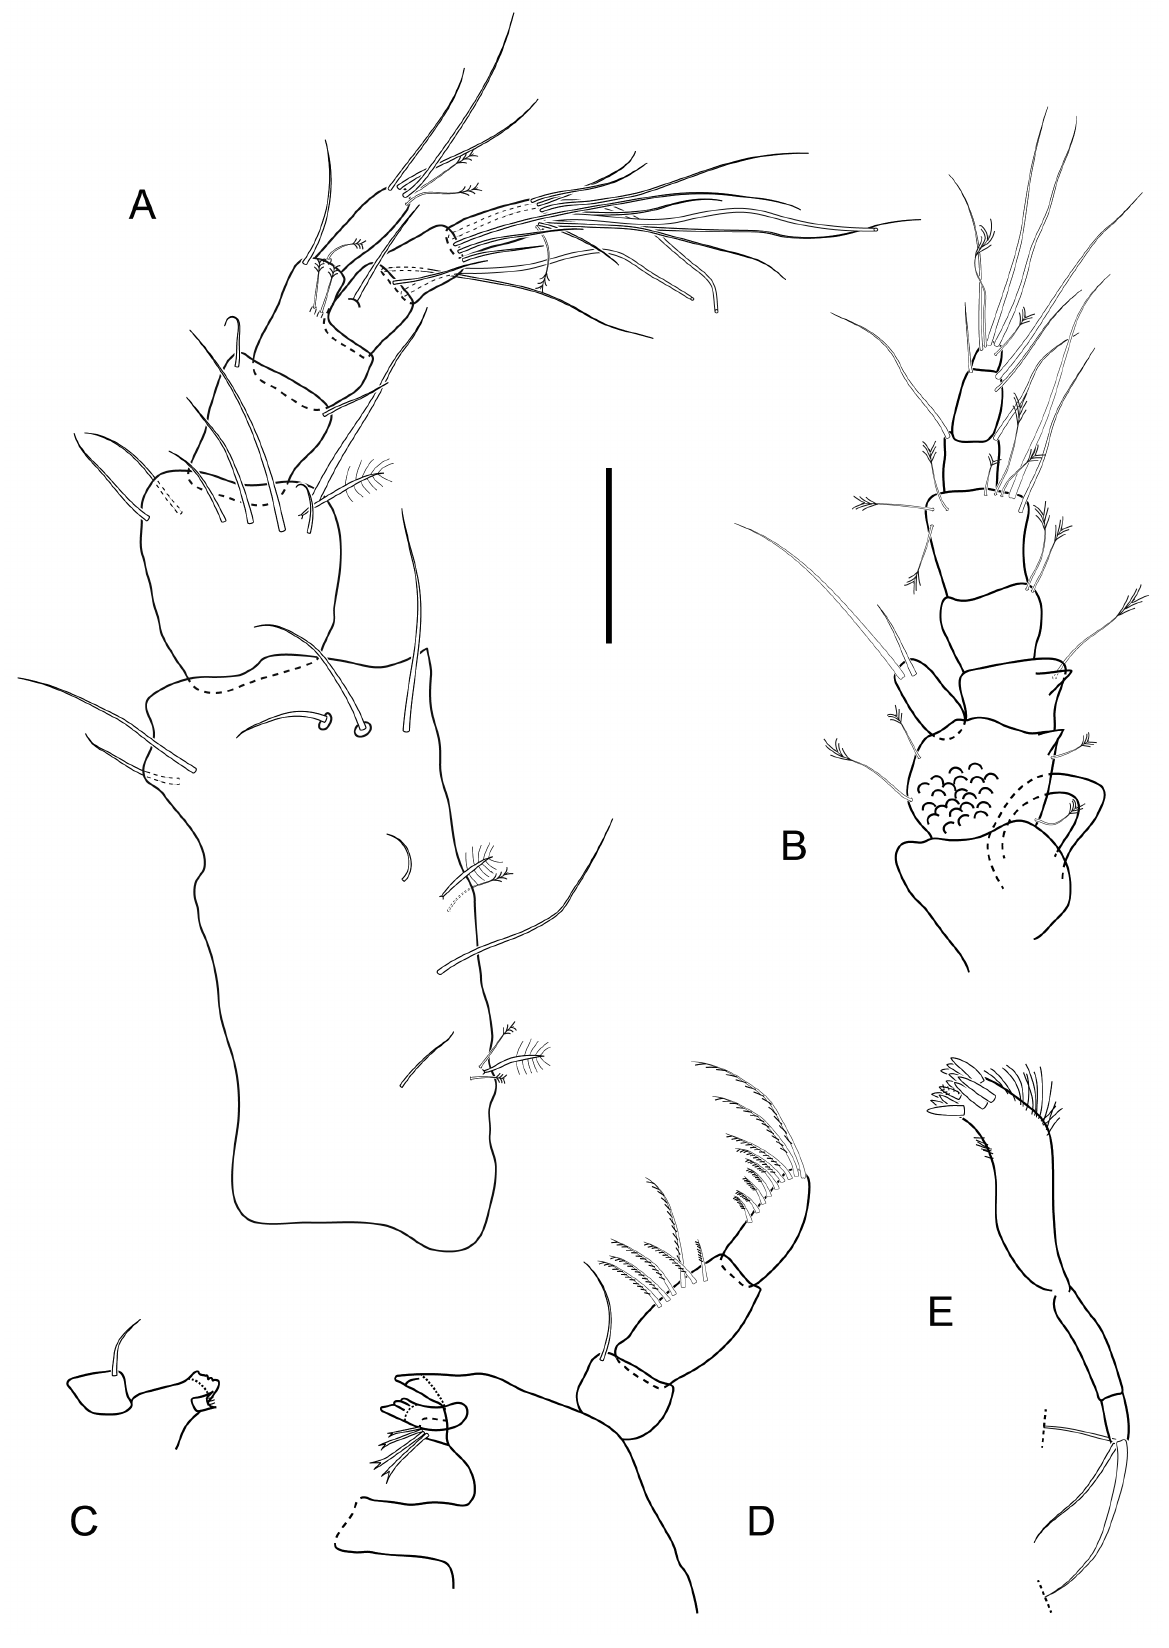
Figure 3. Apseudomorpha brasiliensis sp. nov. Paratype, ovigerous female dissected (MNRJ 29857). A Antennule; B antenna; C right mandible; D left mandible; E maxillule. Scale bars: 0.1